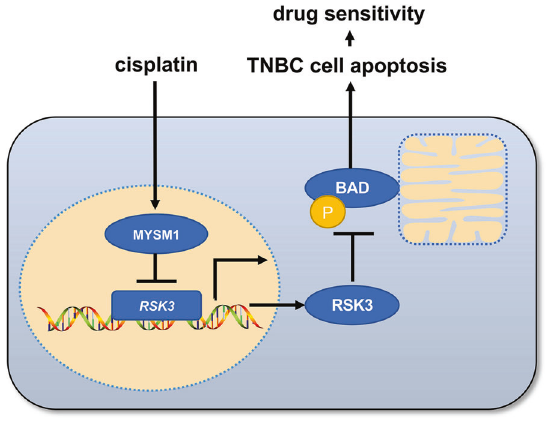
Fig. 6 A schematic representation of MYSM1-mediated RSK3 expression and cisplatin resistance. Upon cisplatin treatment on TNBC cells, MYSM1 represses RSK3 expression, and reduces the phosphorylation of BAD at Ser 112, leading to cell apoptosis and cisplatin